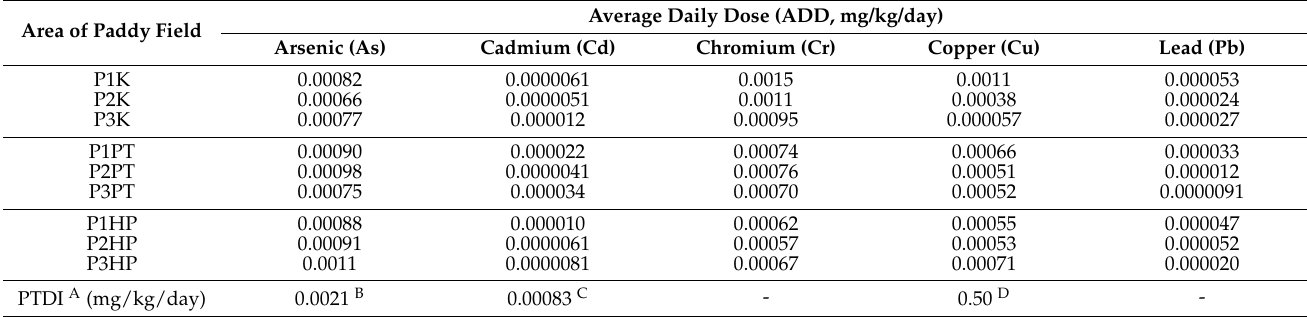
Table 7. The average daily dose (ADD) for heavy metals by children through consumption of rice from